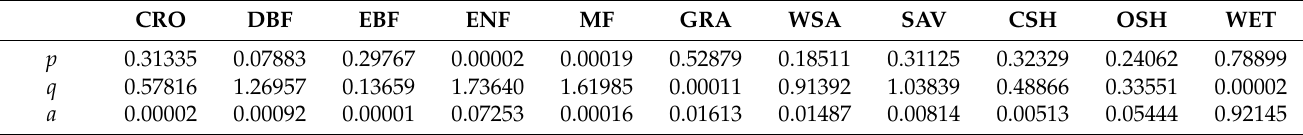
Table A3. Optimized parameters of the NI-LUE model for different vegetation types.